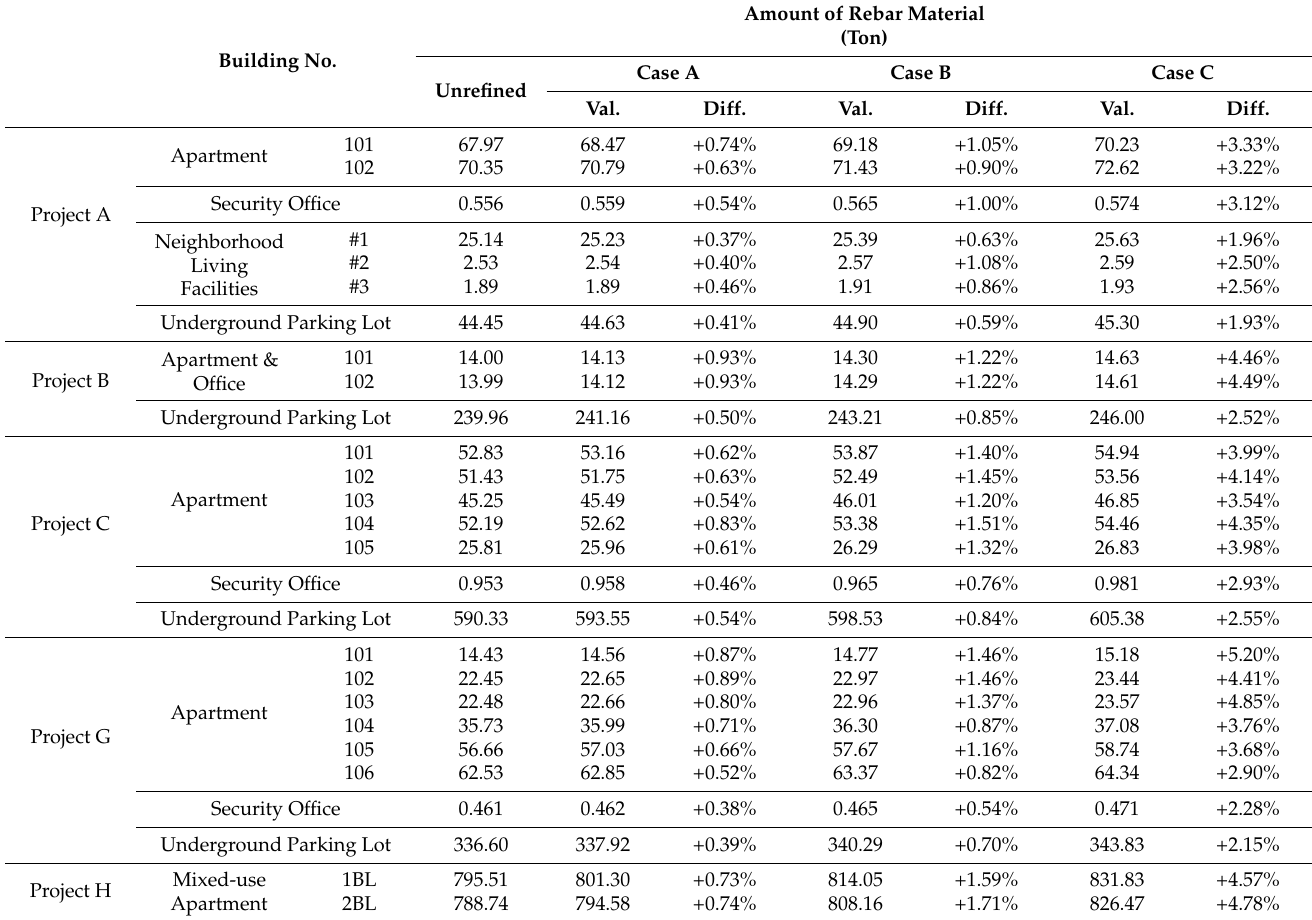
Table A6. Amounts of Rebar Materials for Beam Members and Differentials by Cases.